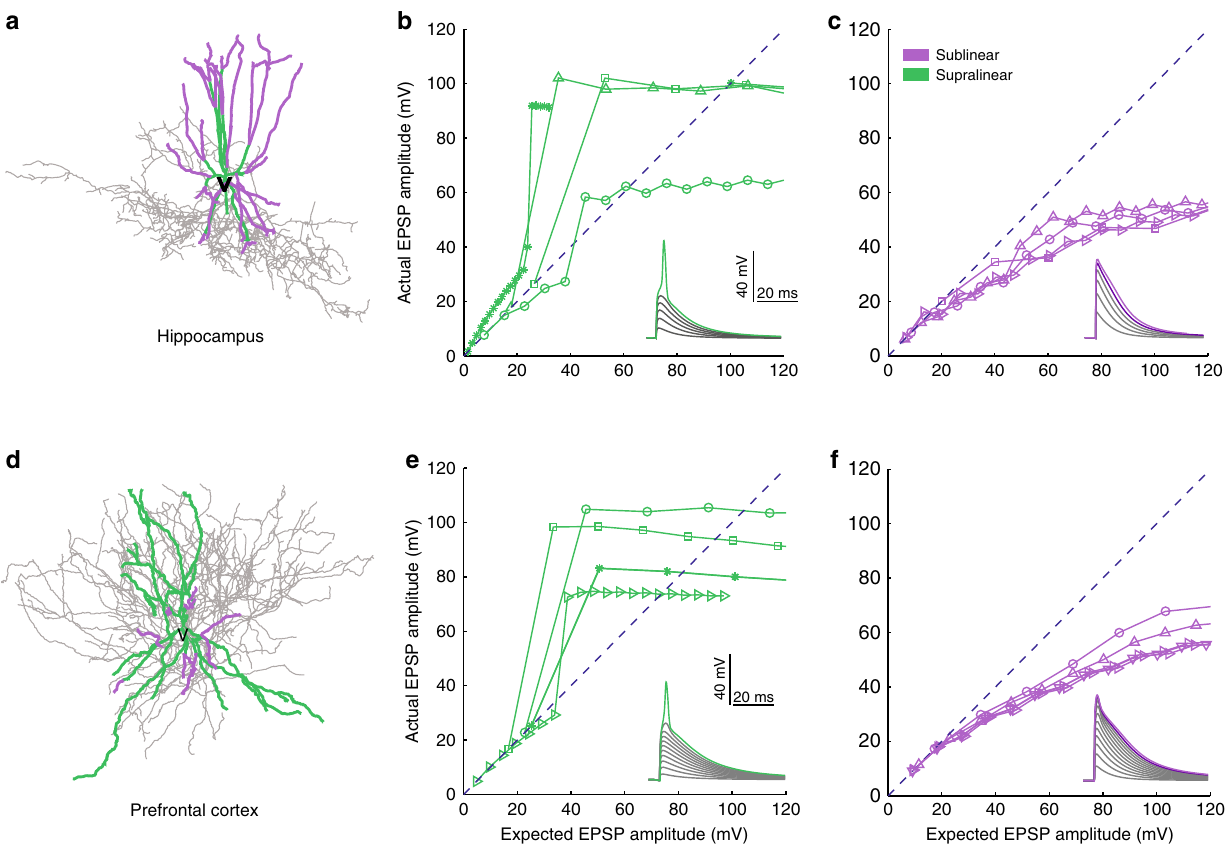
Fig. 2 Bimodal dendritic integration in multi-compartmental FS BC models. Examples of hippocampal ( a ) and PFC ( d ) FS BC morphological reconstructions. Representative input-output curves from supralinear ( b , e ) and sublinear ( c , f ) dendritic branches in hippocampal (top) and PFC (bottom) models, in response to synaptic stimulation. Increasing numbers of synapses (from 1 to 20 with step = 1) are uniformly distributed within each stimulated branch and are activated with a single pulse. The y -axis shows the amplitude of the dendritic EPSP caused by synaptic activation while the x -axis shows the expected EPSP amplitude that would result from the linear summation of synaptic EPSPs. The dashed line indicates linear summation. Insets show representative